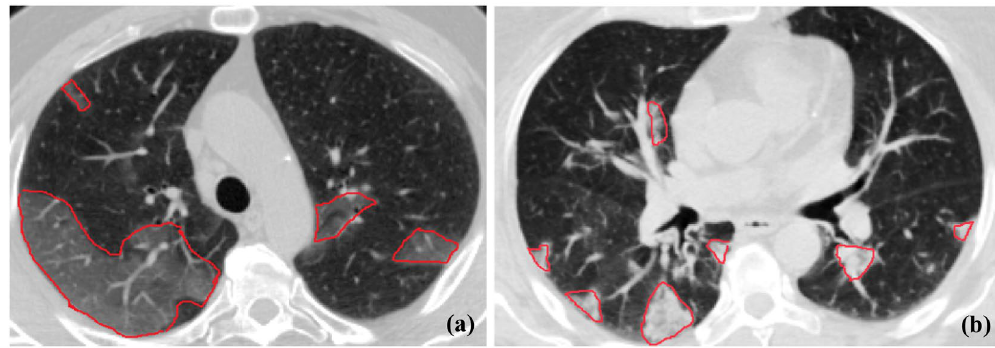
Figure 1. The most commonly observed CT patterns in COVID-19 pneumonia: ( a ) GGO pattern, and; ( b ) Consolidation pattern. Infection regions have been identified with red borders 13